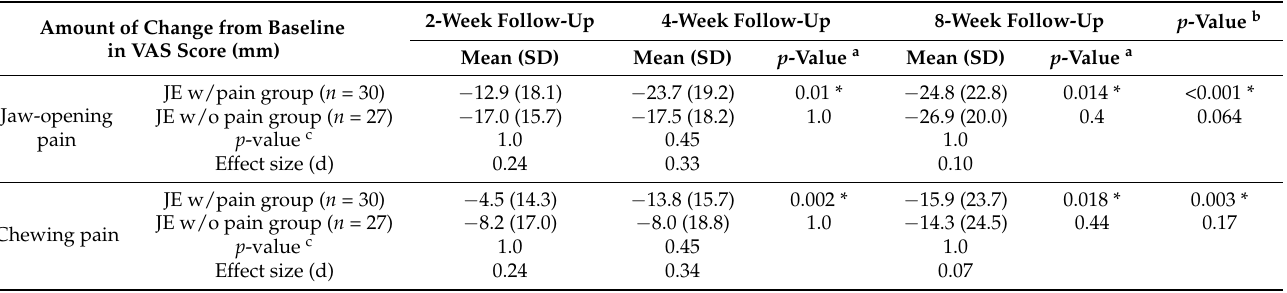
Table 2. Changes in temporomandibular disorders (TMDs) pain intensity in the two groups.